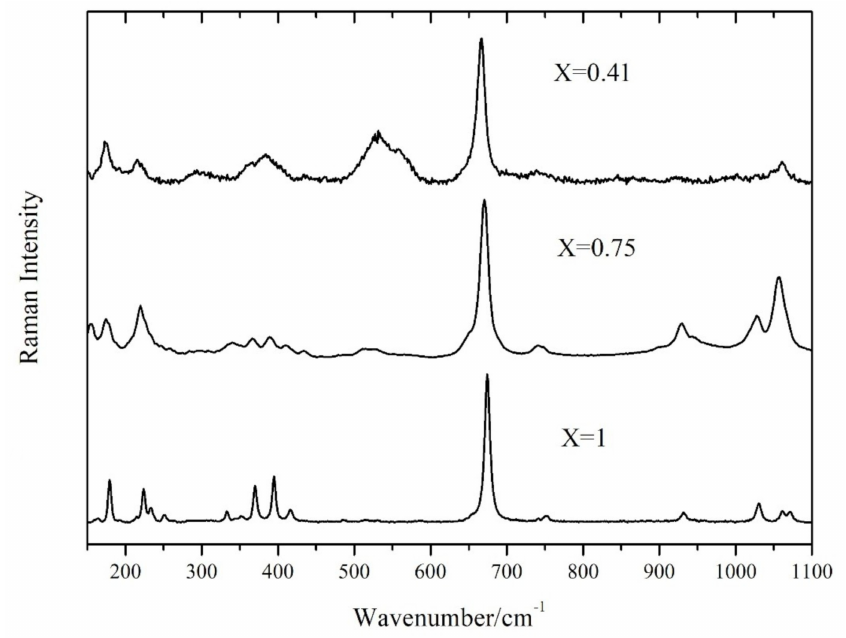
Figure 1. Raman spectra at low wavenumbers of di ff erent minerals of tremolite Fe-actinolite series with di ff erent X